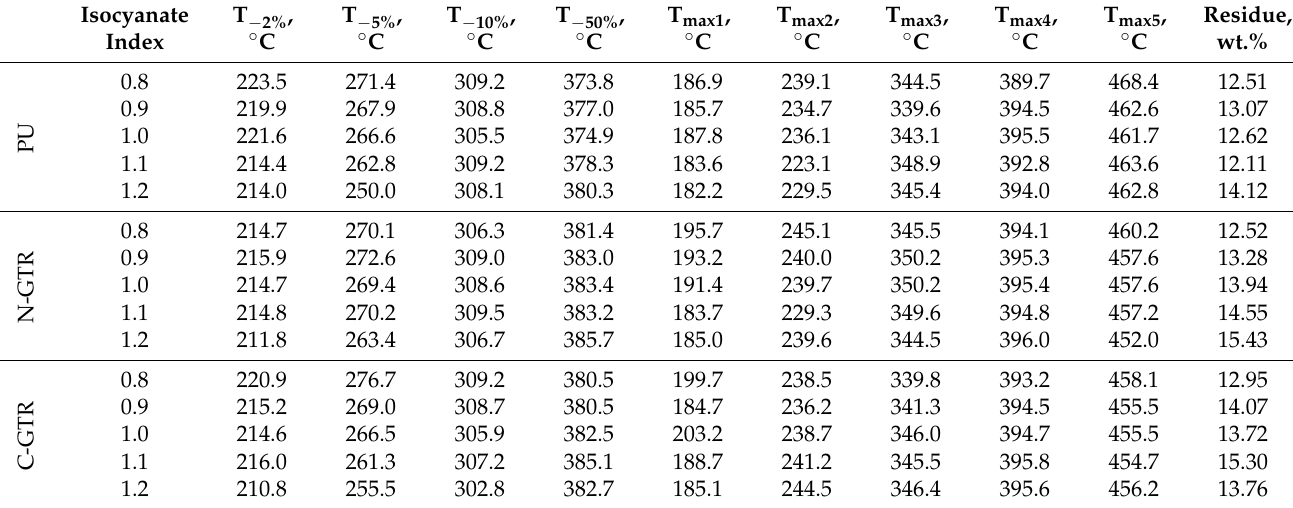
Table 5. Results of thermogravimetric analysis of prepared PU foams and PU/GTR